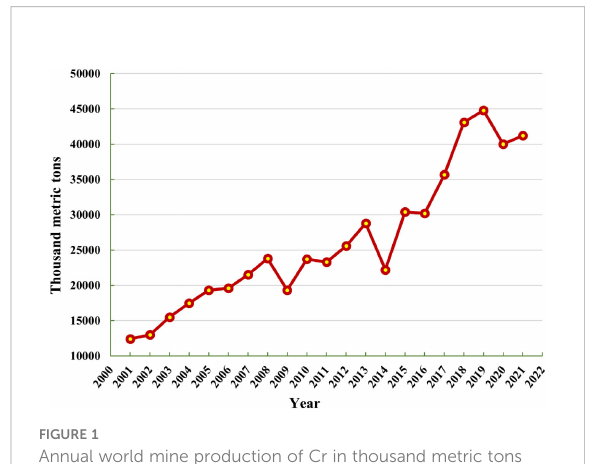
FIGURE 1 Annual world mine production of Cr in thousand metric tons (source, U.S.G.S. (United States Geological Survey),